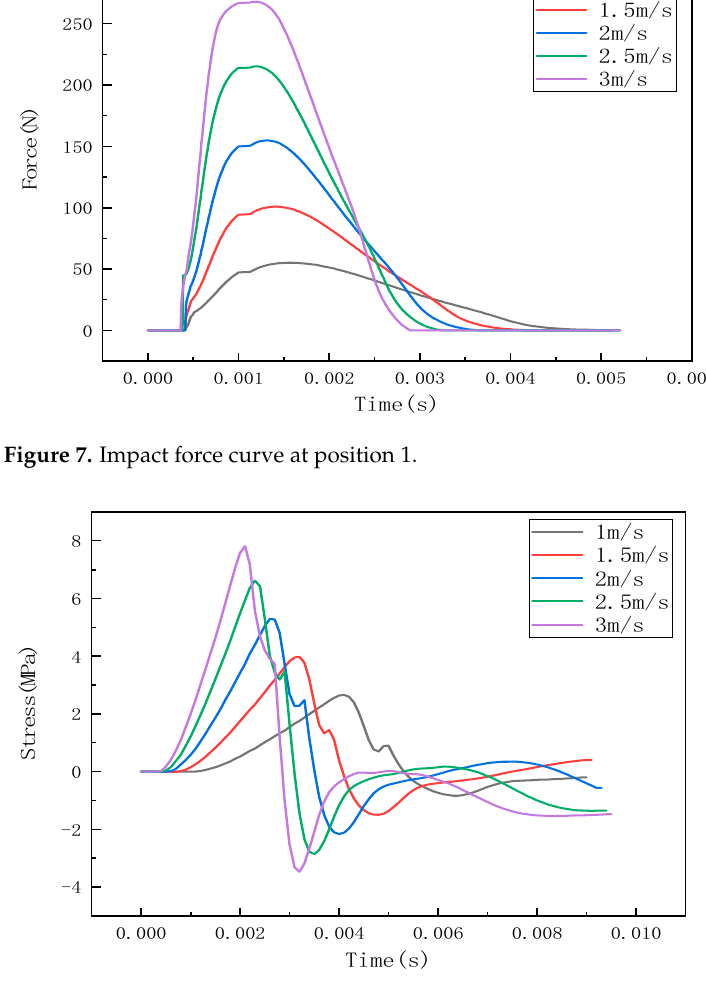
Figure 8. Stress curve of detection point at impact at position 1.